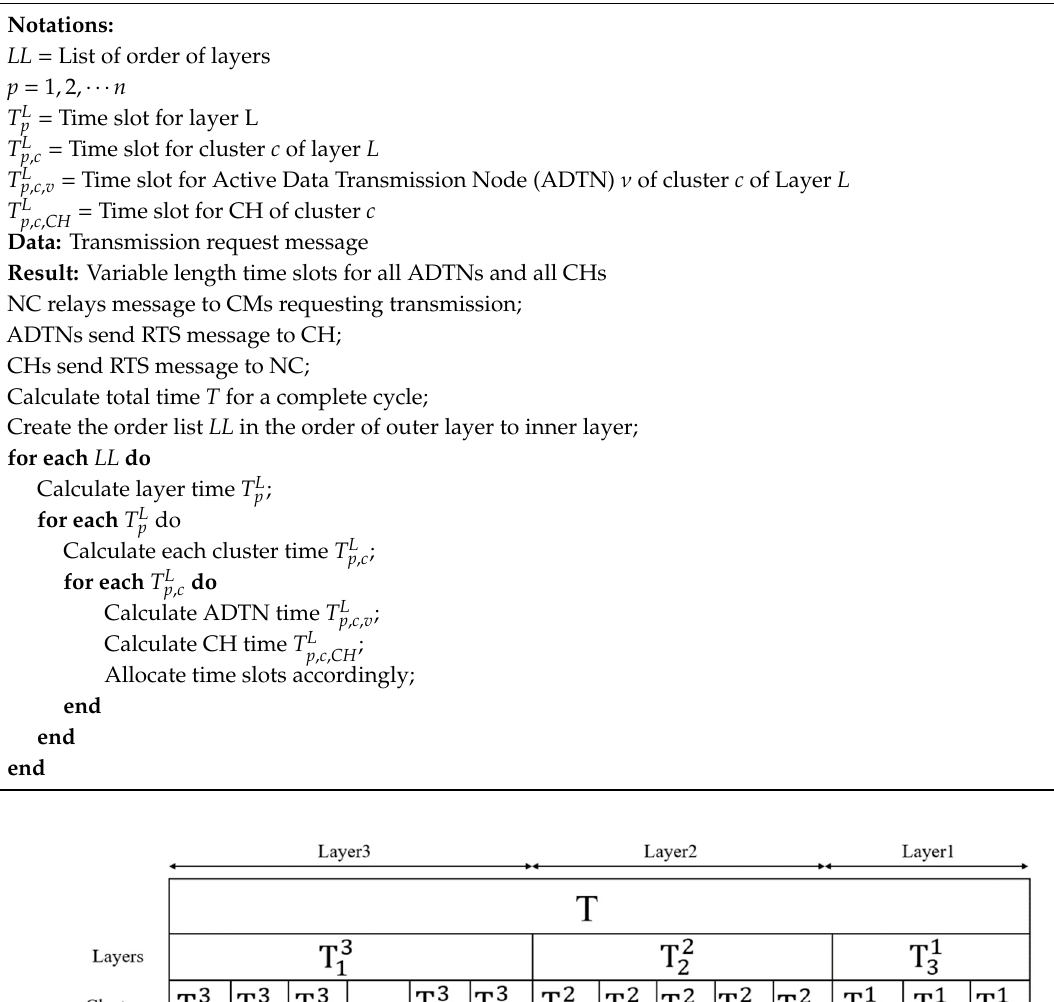
Algorithm 3 TSA Algorithm